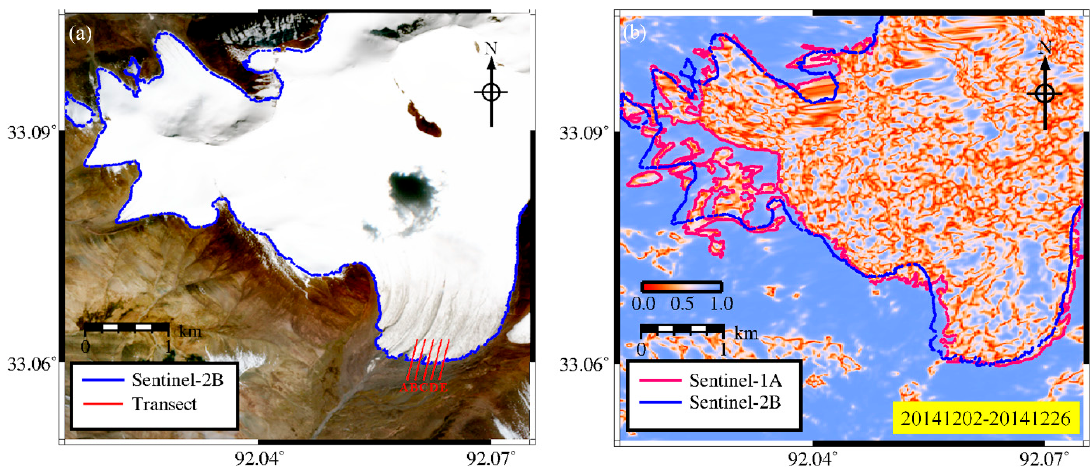
Figure 9. ( a ) shows the DDG boundaries (solid blue curves) extracted using the Sentinel-2B optical image collected on 27 September 2017 by visual interpretation. ( b ) shows the DDG boundaries (solid red curves) extracted using the Sentinel-1A coherence map related to December of 2014. Five transect lines (solid red lines) in ( a ) are marked for use of later analysis. The solid blue curves in ( a ) are superimposed onto ( b ) for a visual check. Table 3. The Jaccard similarity coefficient of the total area within the DDG boundaries derived for the Sentinel-1A coherence maps selected around July, August, September and December with respect to the Sentinel-2B optical